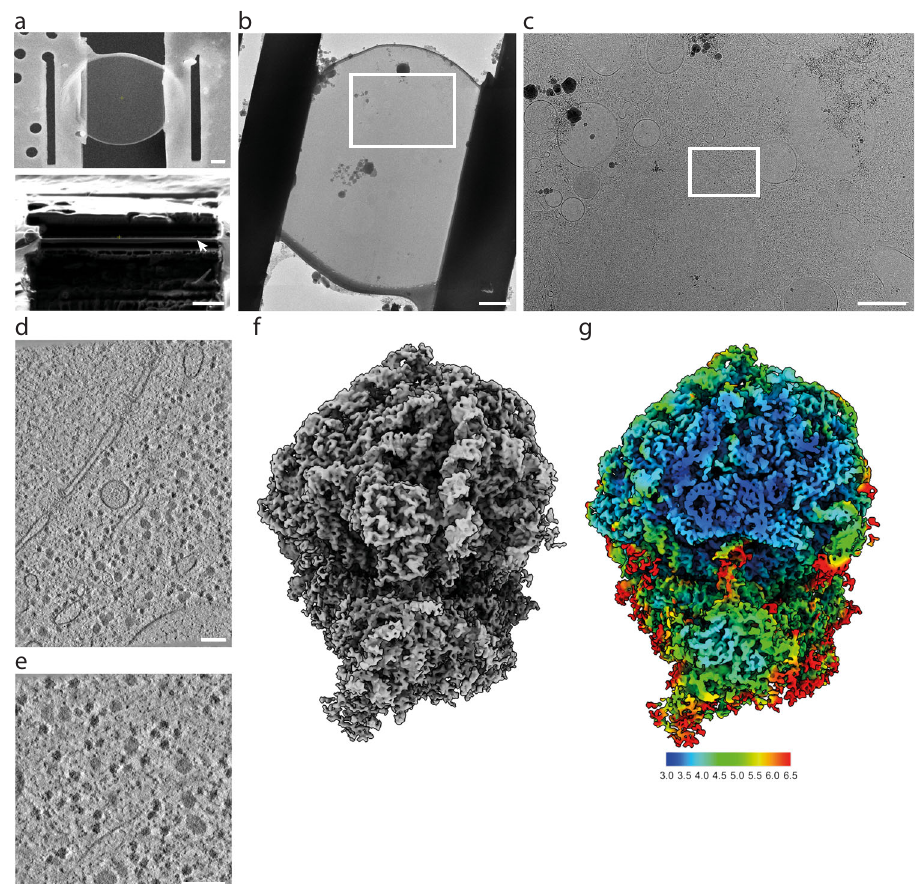
Fig.1|Insituribosomestructureof D.discoideum .a Cryo-FIBmilledlamellaSEM view(top)andFIBview(bottom)ofa D.discoideum cell.ThelamellafrontintheFIB view is indicated by the white arrow. b Cryo-TEM overview of the same lamella, rotatedby~180°comparedto( a topview),whiteboxindicatestheareashownin c . c Higher magni fi cation cryo-TEM overview showing the subcellular context, white box indicates the area of tilt series acquisition. d Virtual slice of one out of 125